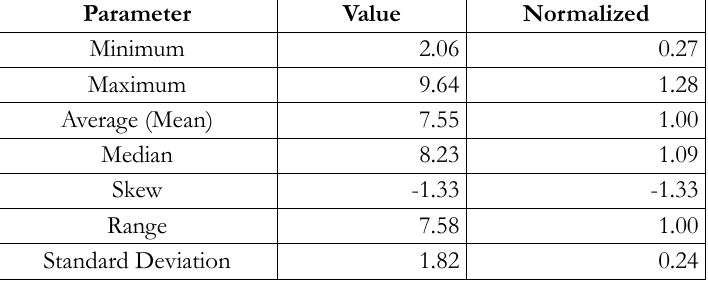
Table 4. Statistics related to the weights of the 100